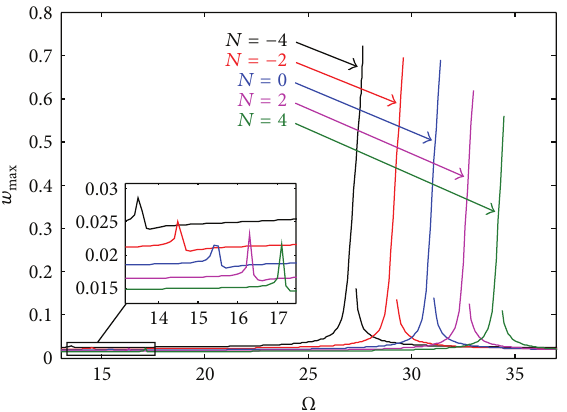
Figure 14: Frequency response curve of different values of residual stress. 𝑁 = 0 means no residual stress is applied to the